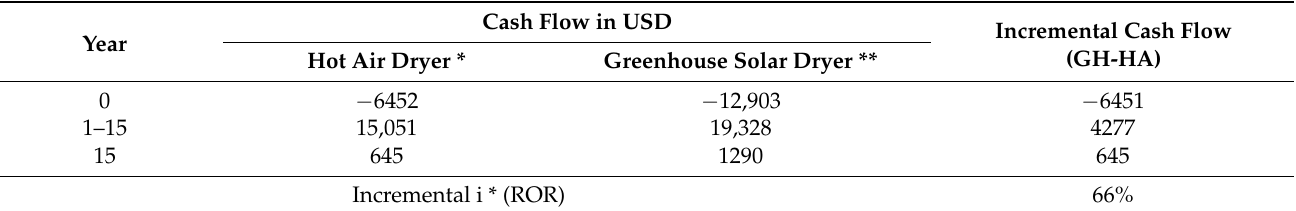
Table 5. Incremental ROR analysis of mango slices using hot air and greenhouse solar